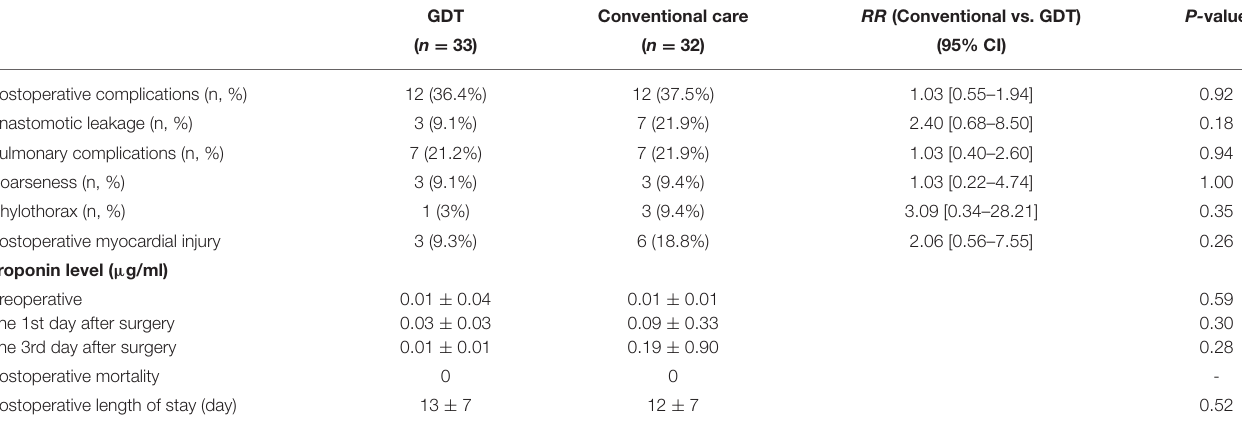
TABLE 2 | Postoperative complications and mortality.